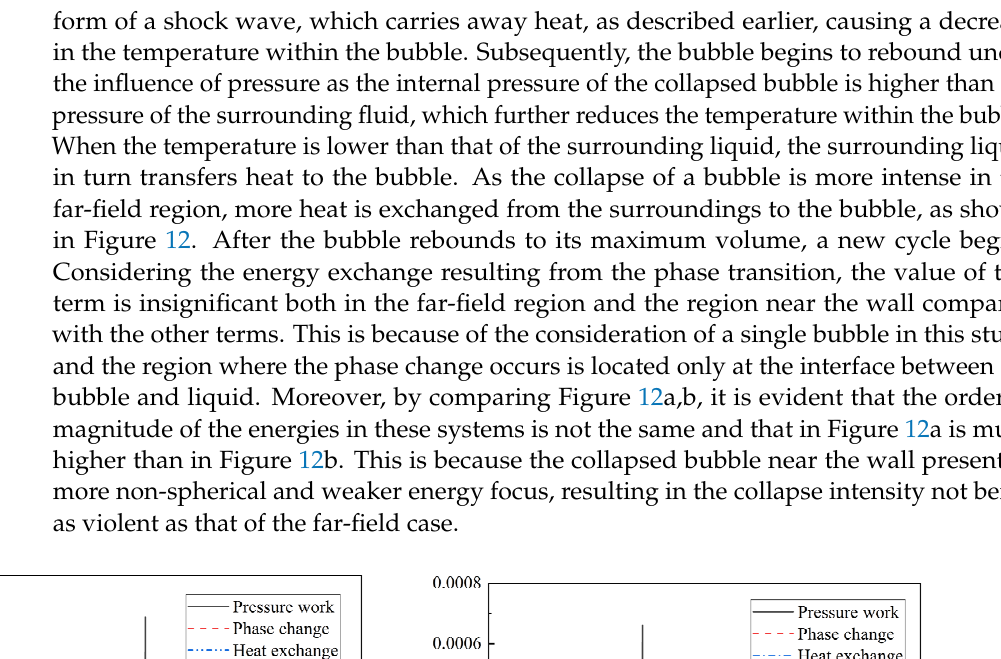
Figure 13. Time-evolution of the bubble acoustic energy. ( a ) Bubble collapse in the far-field region; ( b ) bubble collapse near the wall. 4.4. Influence of Different Stand-Off Distances on the Energy The relationship between γ , the maximum internal energy, maximum acoustic en- ergy, and dissipated energy can be further compared, as shown in Figure 14. Here, the maximum internal energy is obtained from the time integration before the bubble re- bounds, the maximum acoustic energy refers to the acoustic energy emitted after the first bubble collapse, and the dissipated energy is calculated from the initial potential energy minus the maximum potential energy after the bubble rebounds. All three energies tend to decrease initially before increasing with increasing γ . When γ = 4.5, the maximum